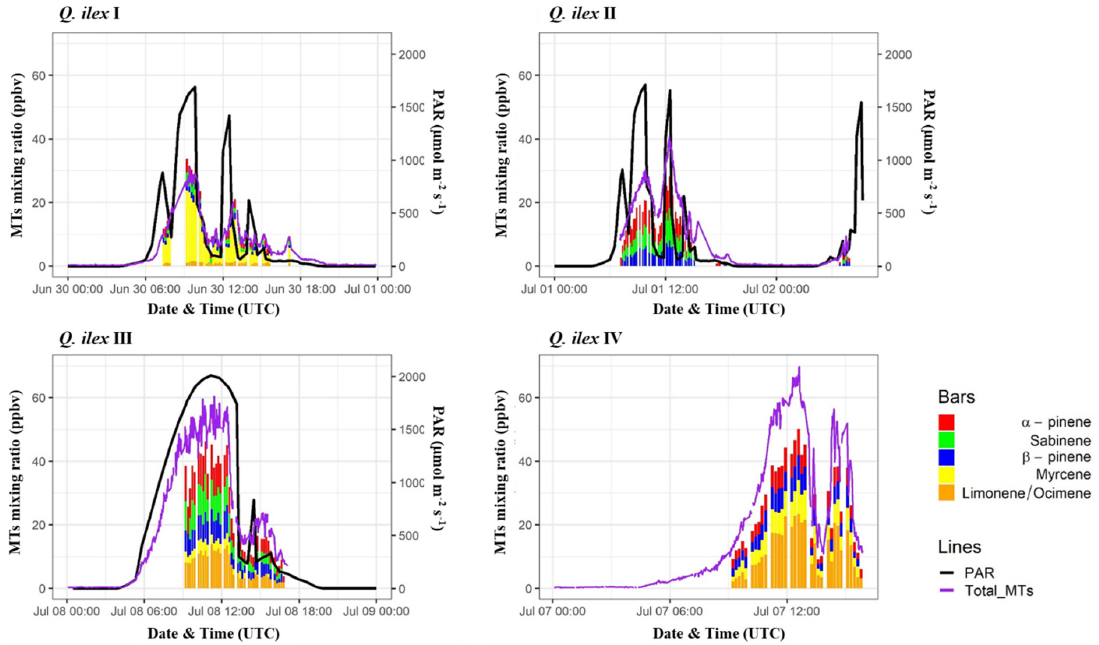
Figure 6. Diurnal variations of photosynthetically active radiation (PAR) and mixing ratios of individual MTs in the chamber air of the four studied trees. No PAR data are available for Q. ilex